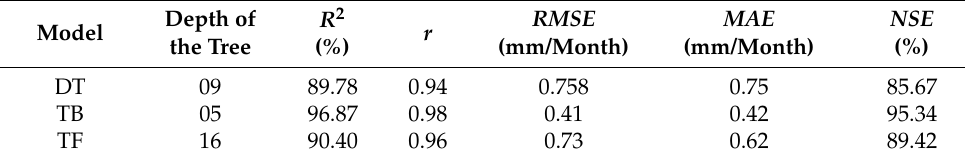
Table 3. Results obtained in the training process for the selected tree models.